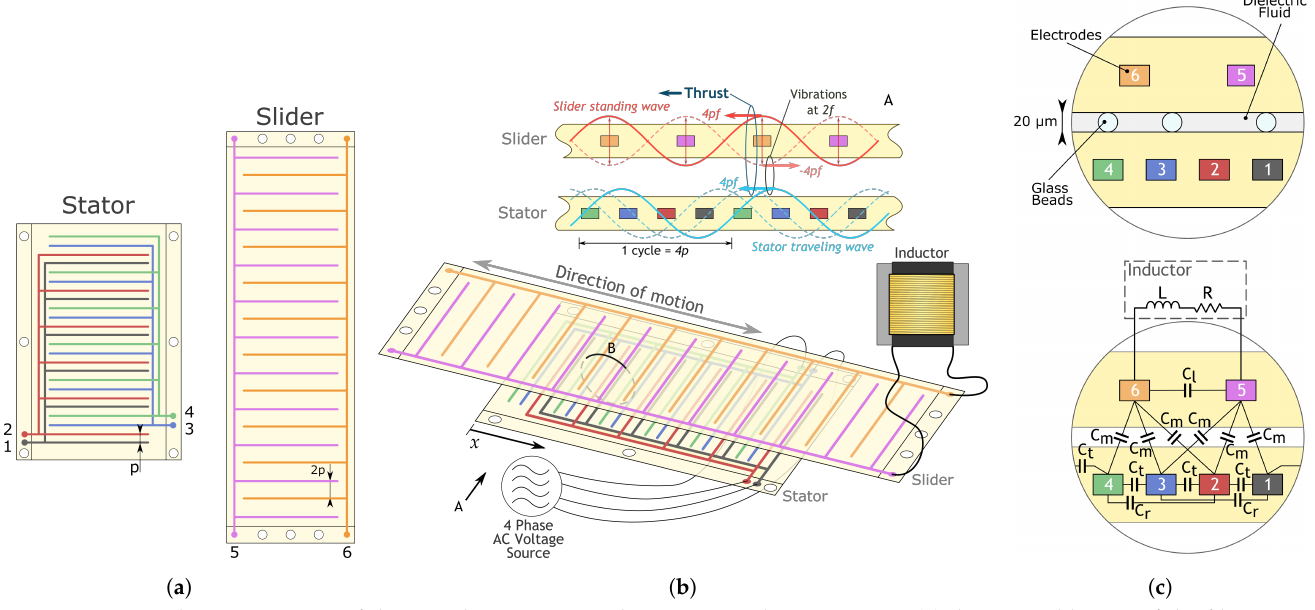
Figure 1. Schematic images of the 2–4 phase resonant electrostatic induction motor: ( a ) the general layout of the films; ( b ) their typical arrangement, external circuit components and working principle; and ( c ) a more detailed section view with identification of the discrete capacitive elements (designations are the ones introduced in this